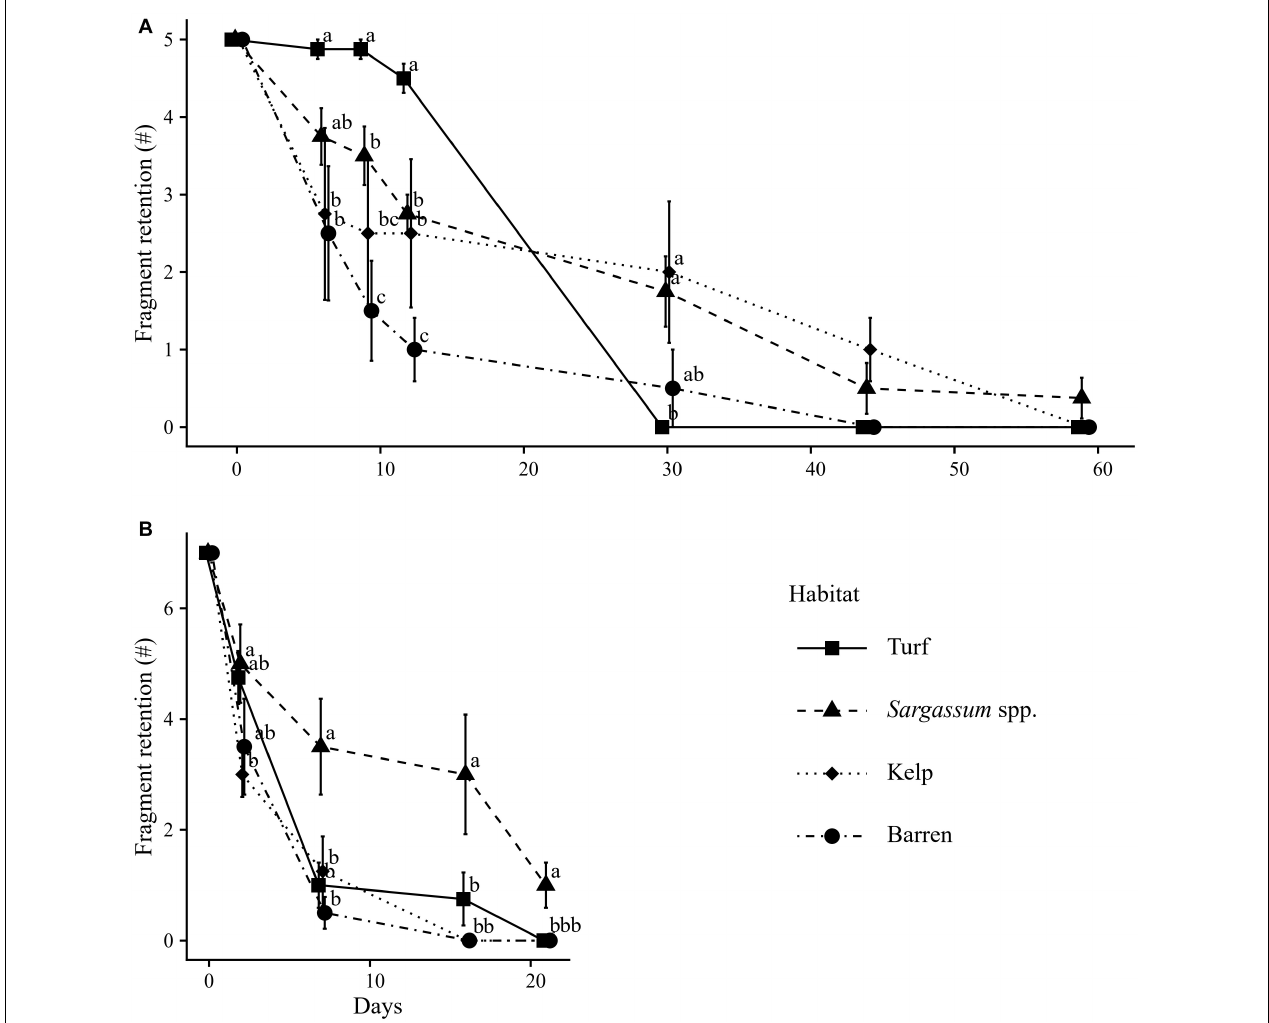
FIGURE 8 | Fragment retention success ( ± SE) per habitat at days since the initial addition of five fragments per mat on 16/02/2015 (A) or seven fragments per mat on 11/01/2016 (B) . 8 Replicate plots for Sargassum and Turf habitat for the 2015 experiment, four replicate plots for all others. Different letters indicate differences among substrates ( p < 0.05) per sampling round. Note the different scales of the y